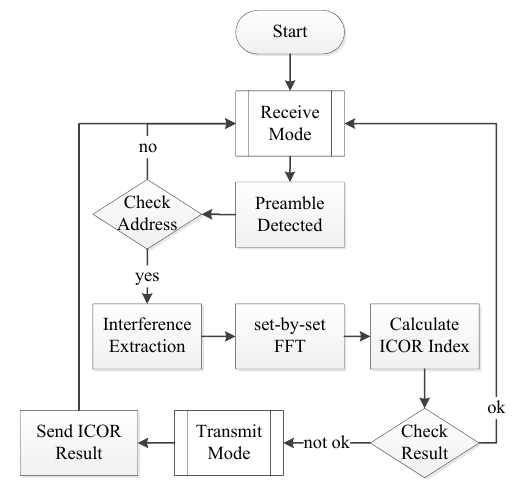
Figure 13. Procedure to mitigate interference with ICOR In order to minimize the additional overhead for the ICOR feedback, we propose to adapt an IEEE 802.15.4